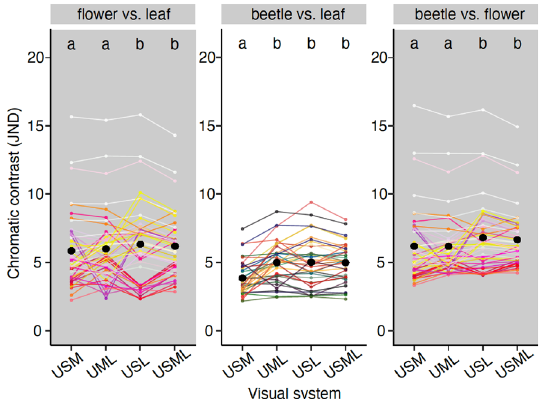
Figure 2. Comparison of chromatic contrast for visual systems with different photoreceptor combinations: USM (UVS, SWS, MWS), UML (UVS, MWS, LWS), USL (UVS, SWS, LWS), USML (UVS, SWS, MWS, LWS). Black dots show the means of the representative contrast values in each visual system. Each coloured dot represents the average contrast value of each flower pattern to all leaves (left panel), each beetle colour to all leaves (middle panel) or each flower colour to all beetle colours (right panel). Colours of the dots correspond to the human-visible colour of the flower (left and right panels) or beetle (middle panel) with the lines of the same colour connecting the results between different visual systems. This is for graphical representation only; statistical tests are based on all pairwise combinations of spectra and not averages. Letters on the top of each panel show the significant difference in contrast value between visual systems. Three contrast values > 10 JND are from flowers (2 white and 1 light pink) that have high UV—blue chroma compared to beetles and leaves. The Figure was created using R software version 3.6.3 (https:// www.r- proje ct. org) and modified using Inkscape version 1.0.2 (https:// inksc ape.